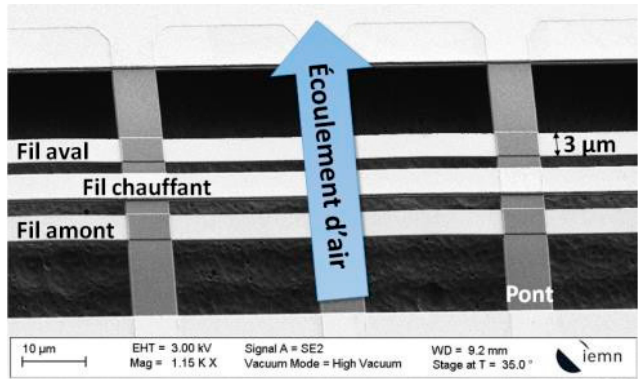
Figure 1. Scanning Electron Microscopy Image of the calorimetric micro-sensor [4].